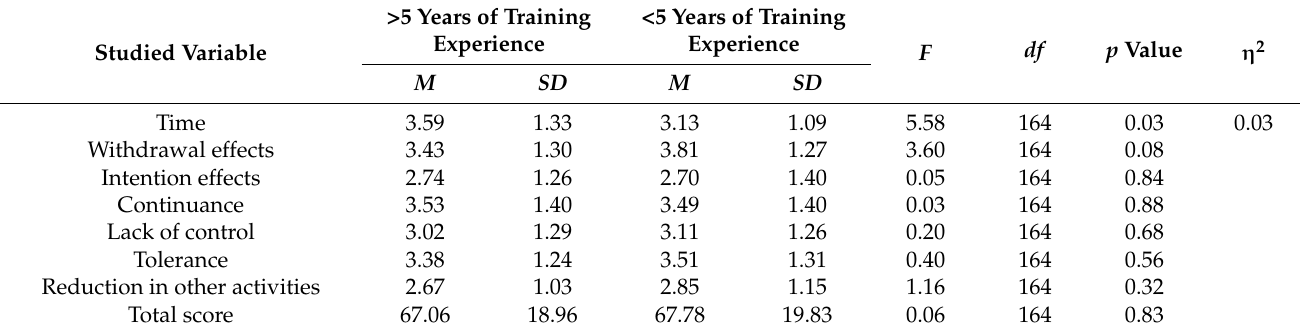
Table 5. Comparison of results by training experience of respondents.